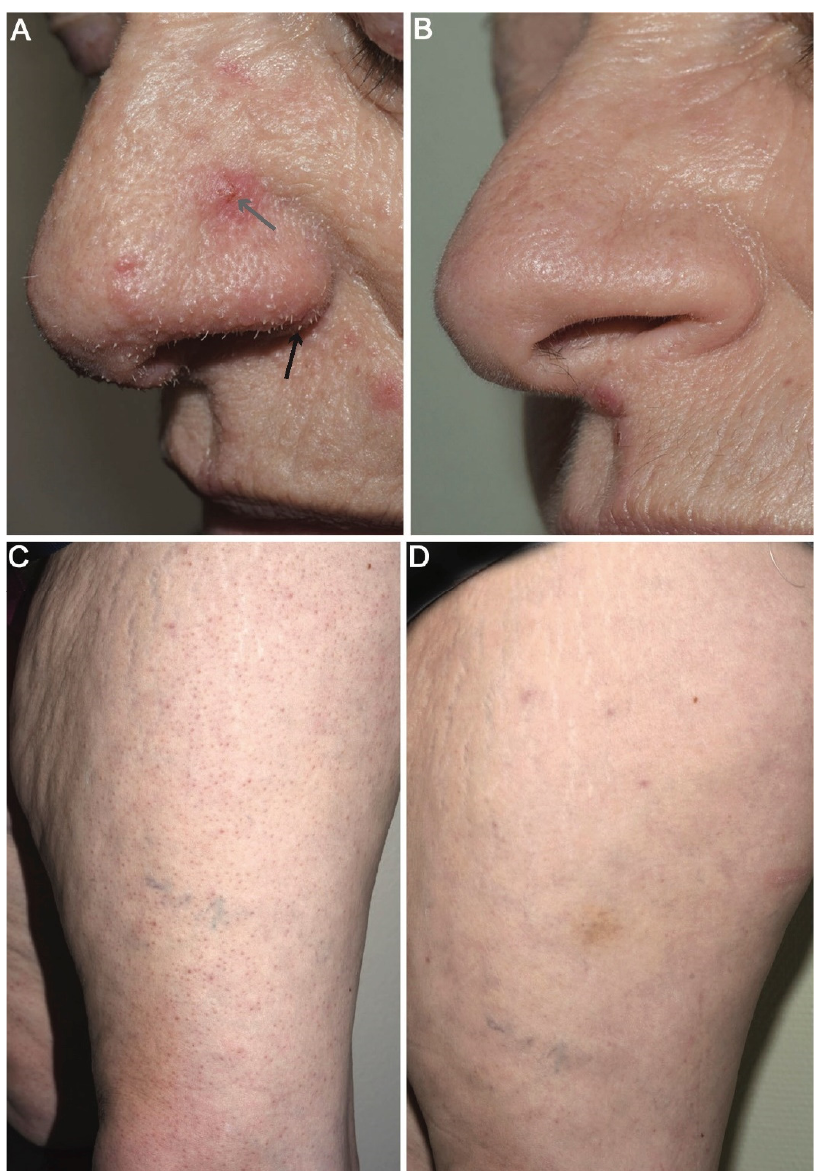
Figure 1. Trichodysplasia spinulosa skin lesions. Trichodysplasia spinulosa (TS) lesions with follicular micropapules (grey arrow) and keratotic spicules (black arrow) over the nose and the left leg 3 months after TS diagnosis (Figure 1A,C) and 16 months after TS diagnosis (Figure 1B,D).